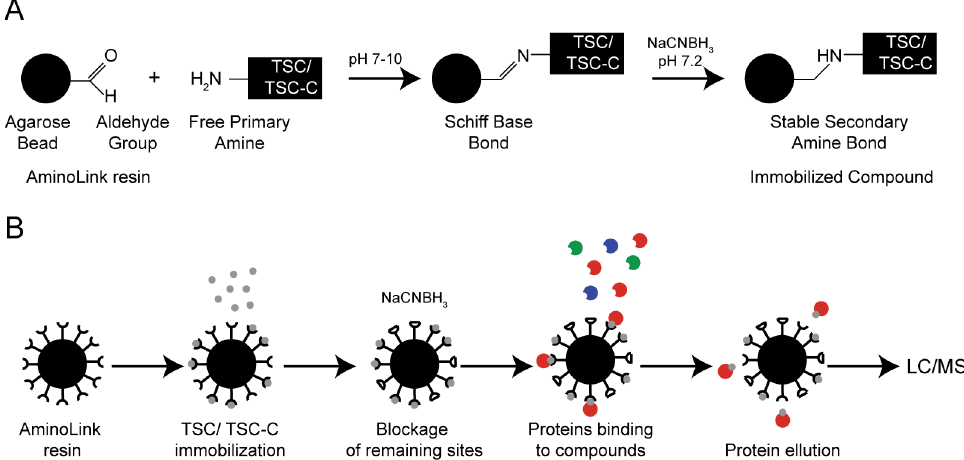
Fig 1. AminoLink resin protocol. Molecular viewof the immobilization step (A) and overallviewof the role protocol (B) AminoLink resins contain aldehyde groups that reacted with the free amino groups of TSC or TSC-C. The aldehyde sites that do not react with the compound are blocked with sodium cyanoborohydride (A). After compound immobilization, the fungal protein extract is added to the resin column. The proteins that interact with the compounds stay in the resin and the rest of the proteins are washed away. The interacting proteins are eluted from the resin, digested, and identified through mass spectrometry (B).